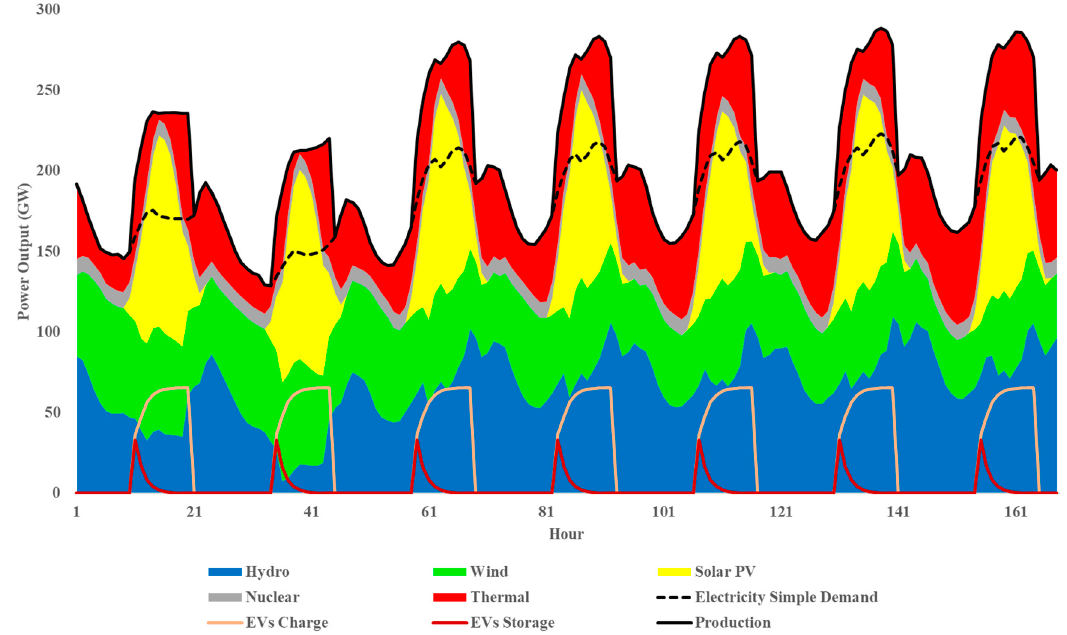
Figure 9. Power output on a spring week for scenario 100EV—Daily charging strategy.